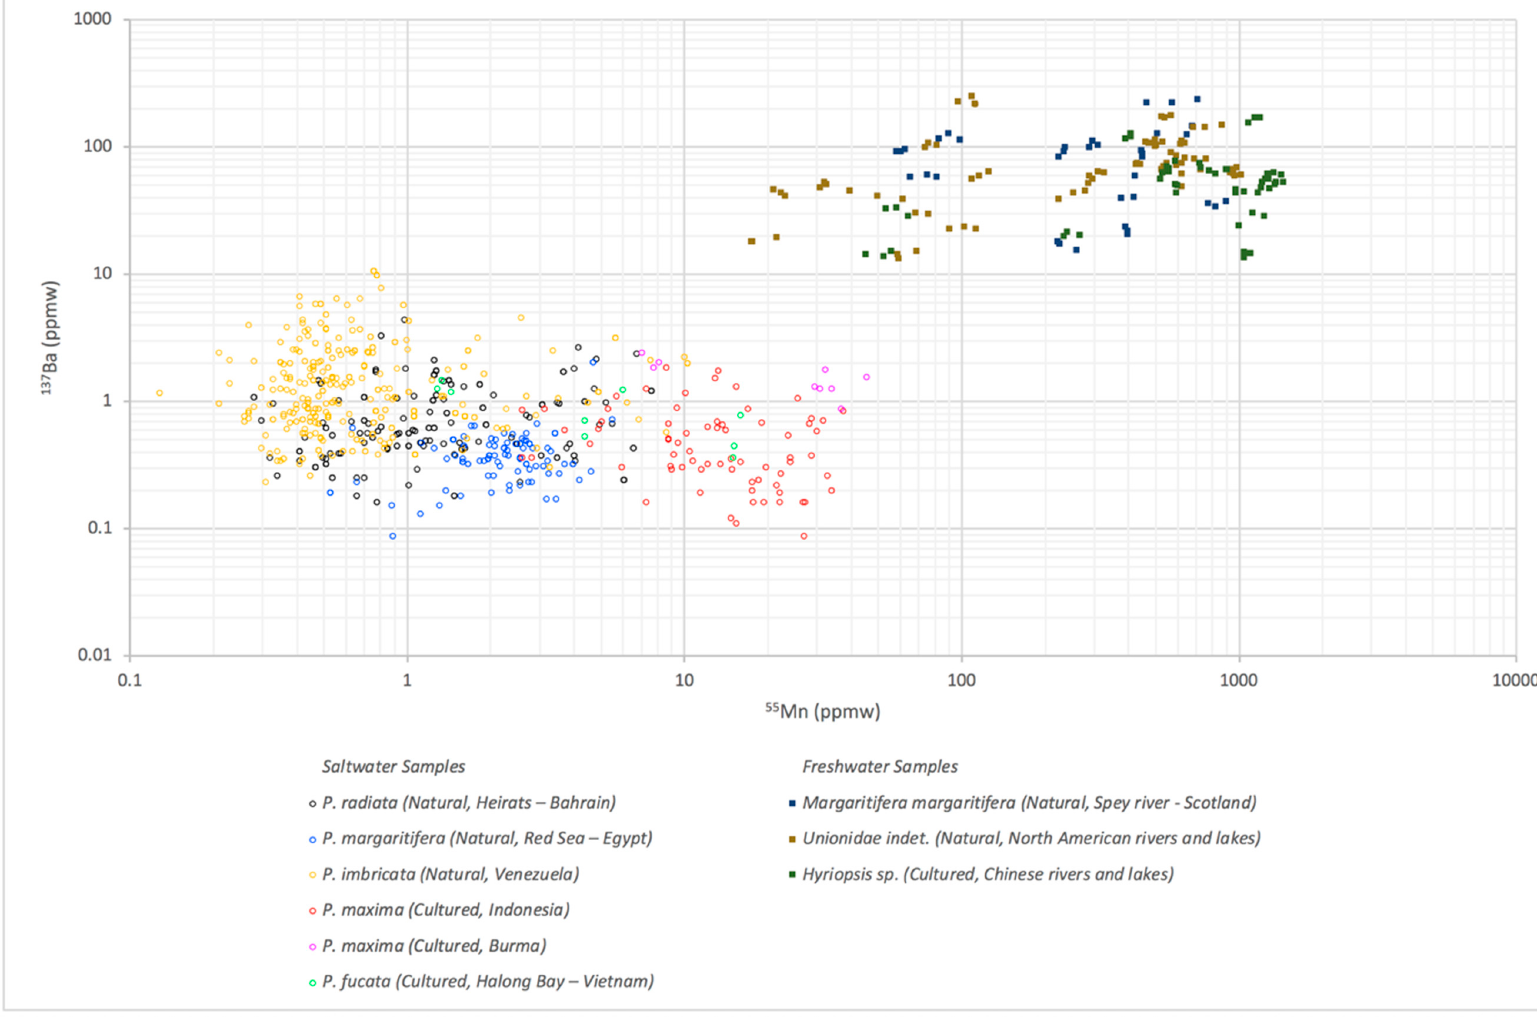
Figure 2. Binary plot of 55 Mn vs. 137 Ba of the studied samples.